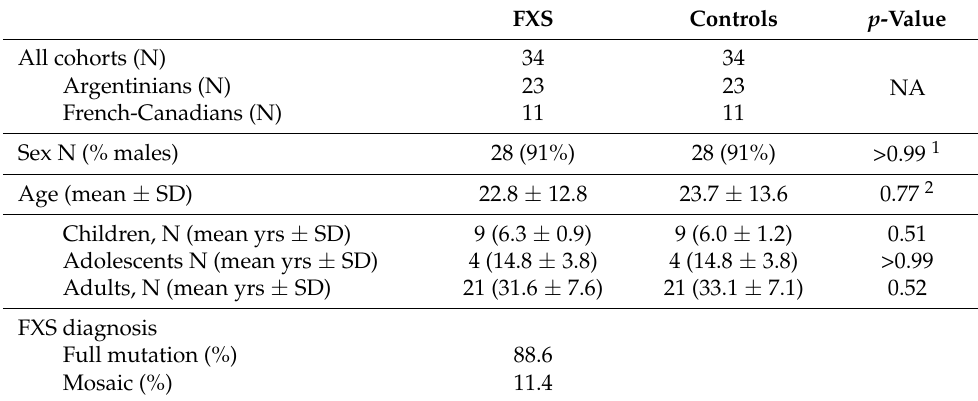
Table 1. Characteristics of